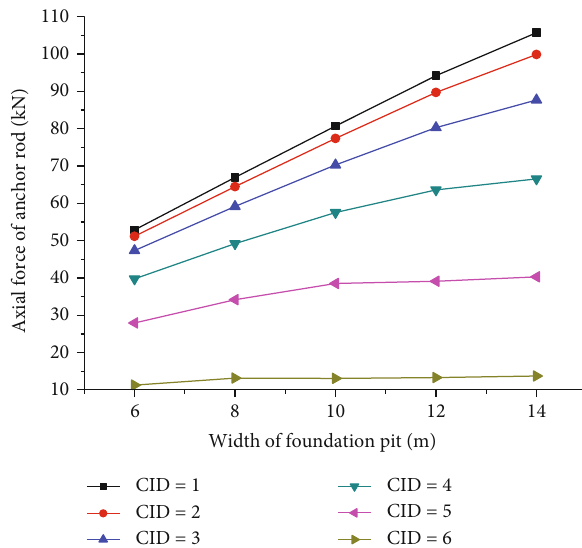
Figure 7: Axial forces of each member of the leftmost anchor bolt at di ff erent distances under the foundation pit.